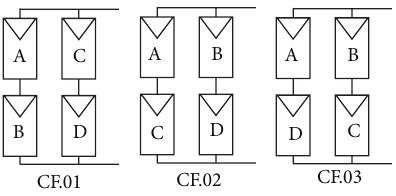
Figure 3: Settings of interest in a 2 × 2 matrix. Table 1: Information System of a 2 × 2 matrix.